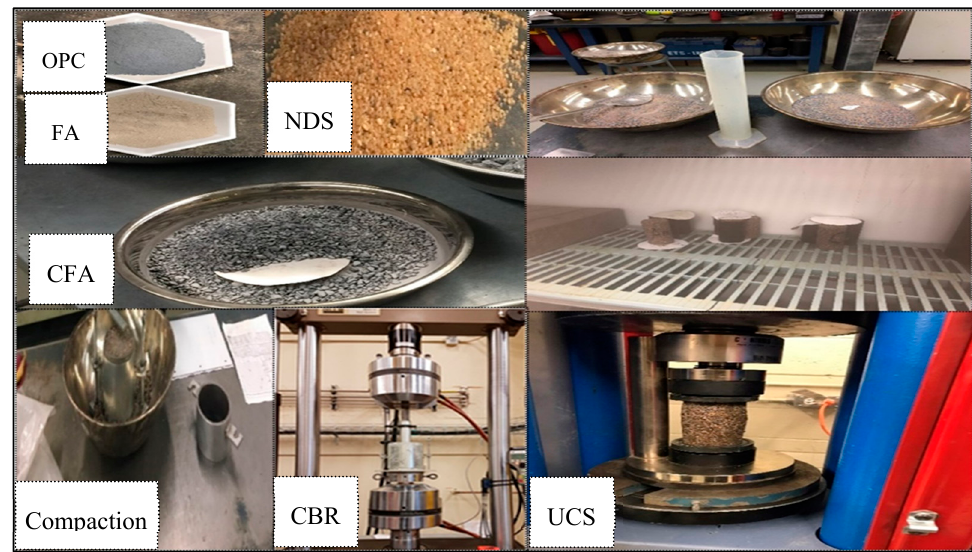
Figure 1. The materials and experimental work.